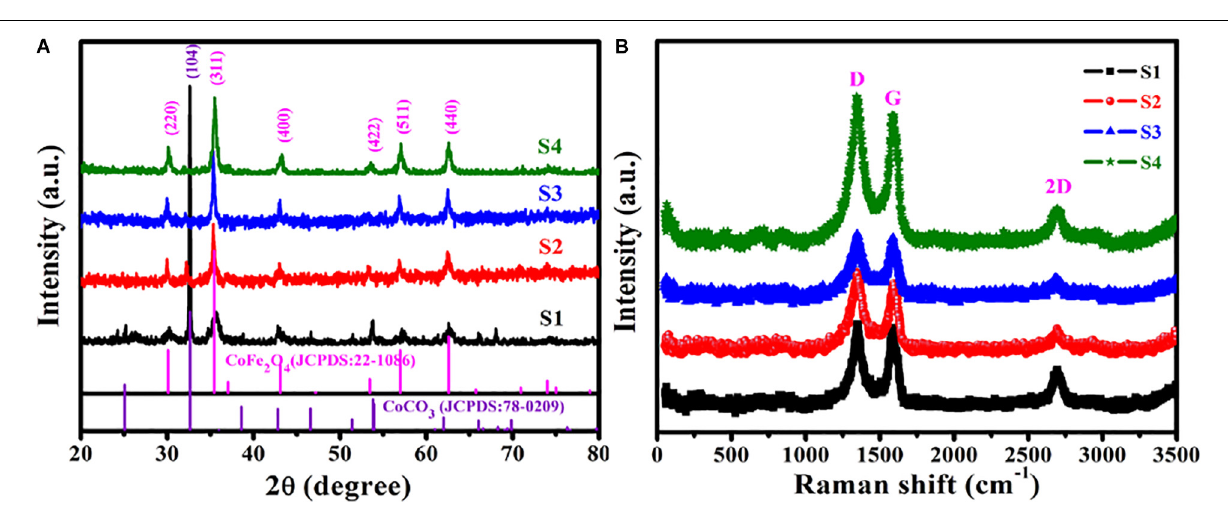
FIGURE 2 | (A) XRD patterns, and (B) Raman spectra of the as-prepared